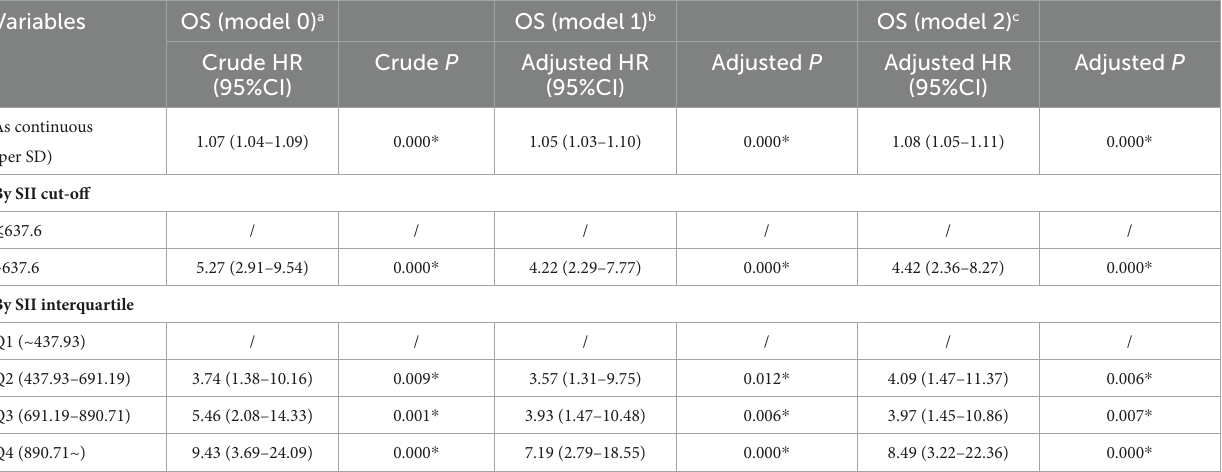
TABLE 2 Univariate and multivariate analysis on the OS of SII.